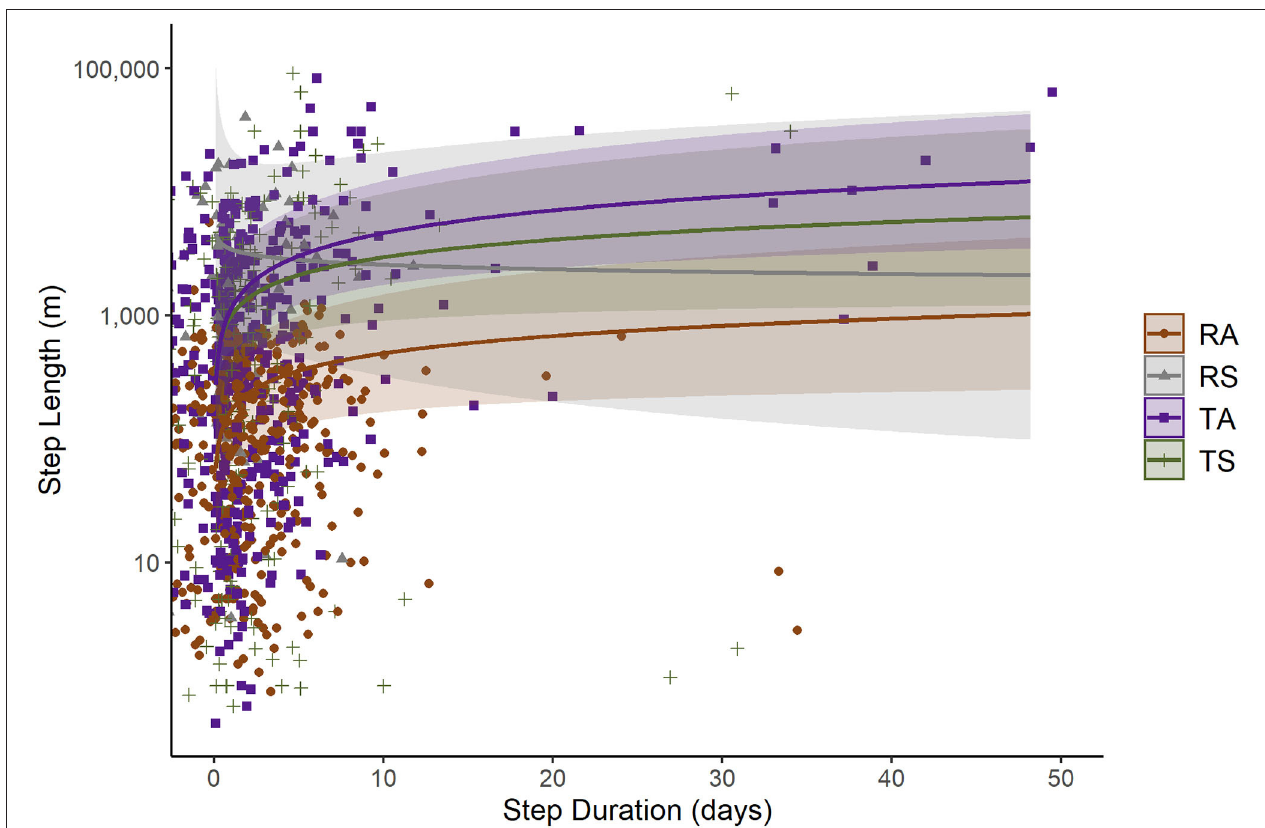
FIGURE 4 | Relationship between step length (in river m) and step duration (in days) for beavers (RA, resident adult; RS, resident subadult; TA, translocated adult; TS, translocated subadult) monitored in desert rivers, east-central Utah, USA, from May 2019 to March 2021. Lines and shaded 95% Confidence Intervals only include the fixed effects from the back-transformed predicted values of a log-log regression linear mixed model (marginal R 2 = 0.30, conditional R 2 = 0.51, n = 600). We held all other covariates included in the model constant for visualization purposes (medium river discharge category only, PIA detections only, mean NDVI value, and mean time since